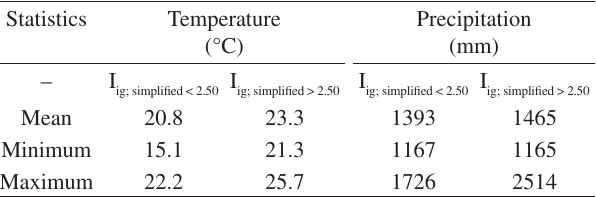
Table 8. Descriptive statistics of the parameters of the populations of